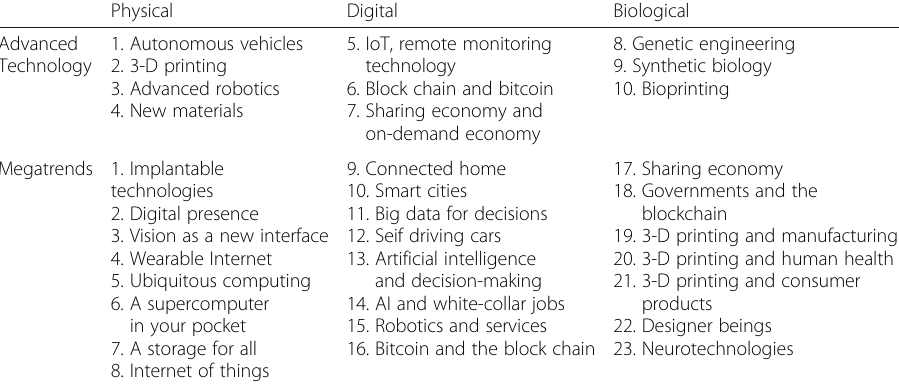
Table 3 10 Advanced Technologies and 23 Megatrends in the Fourth Industrial Revolution Physical